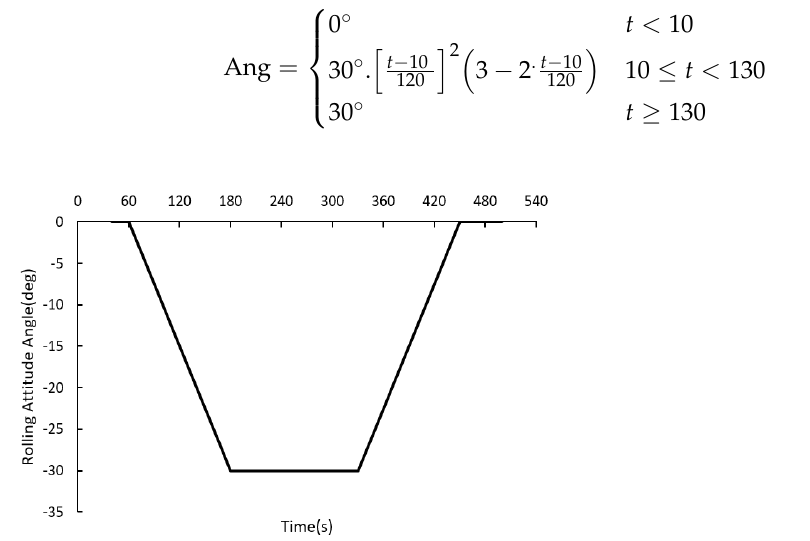
Figure 11. Time history of rotation angle in orbit steering [36].